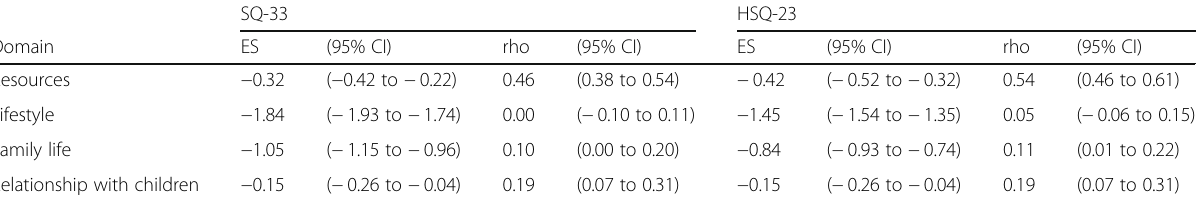
Table 3 Effect size (ES) and Spearman ’ s rho for the original and for the revised domain